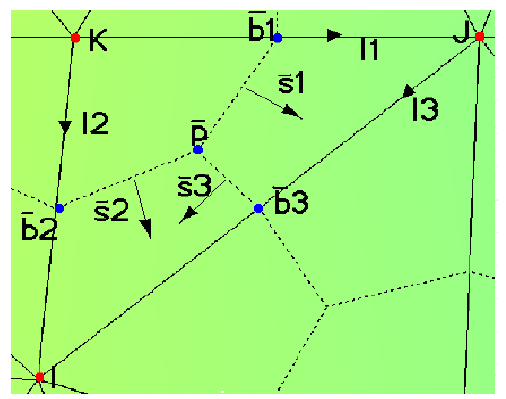
Figure 3. Simple primal-dual cell for assemble